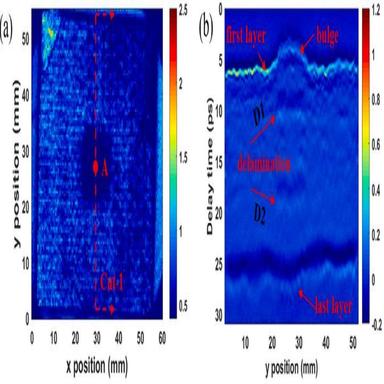
Initial THz C-scan and corresponding B-scan by THz TOFT. (a) C-scan of the sample based on the peak-to-valley over the entire time-domain THz TOFT signal range. (b) Corresponding B-scan at the cross section Cut-1.